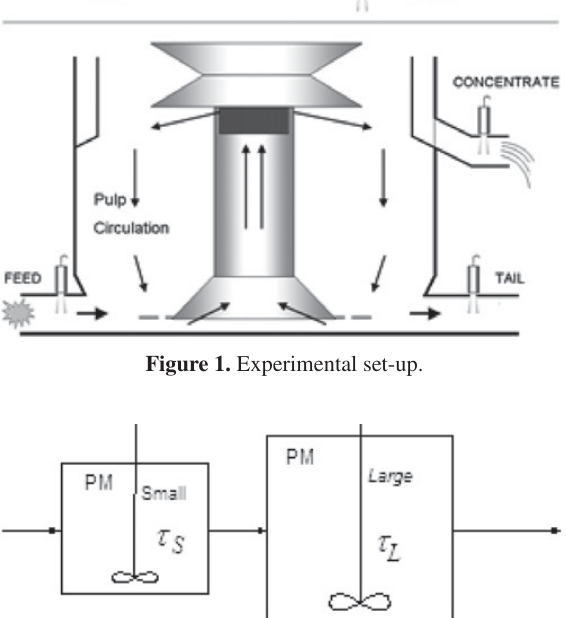
Figure 2. Large and small tank-in-series model.